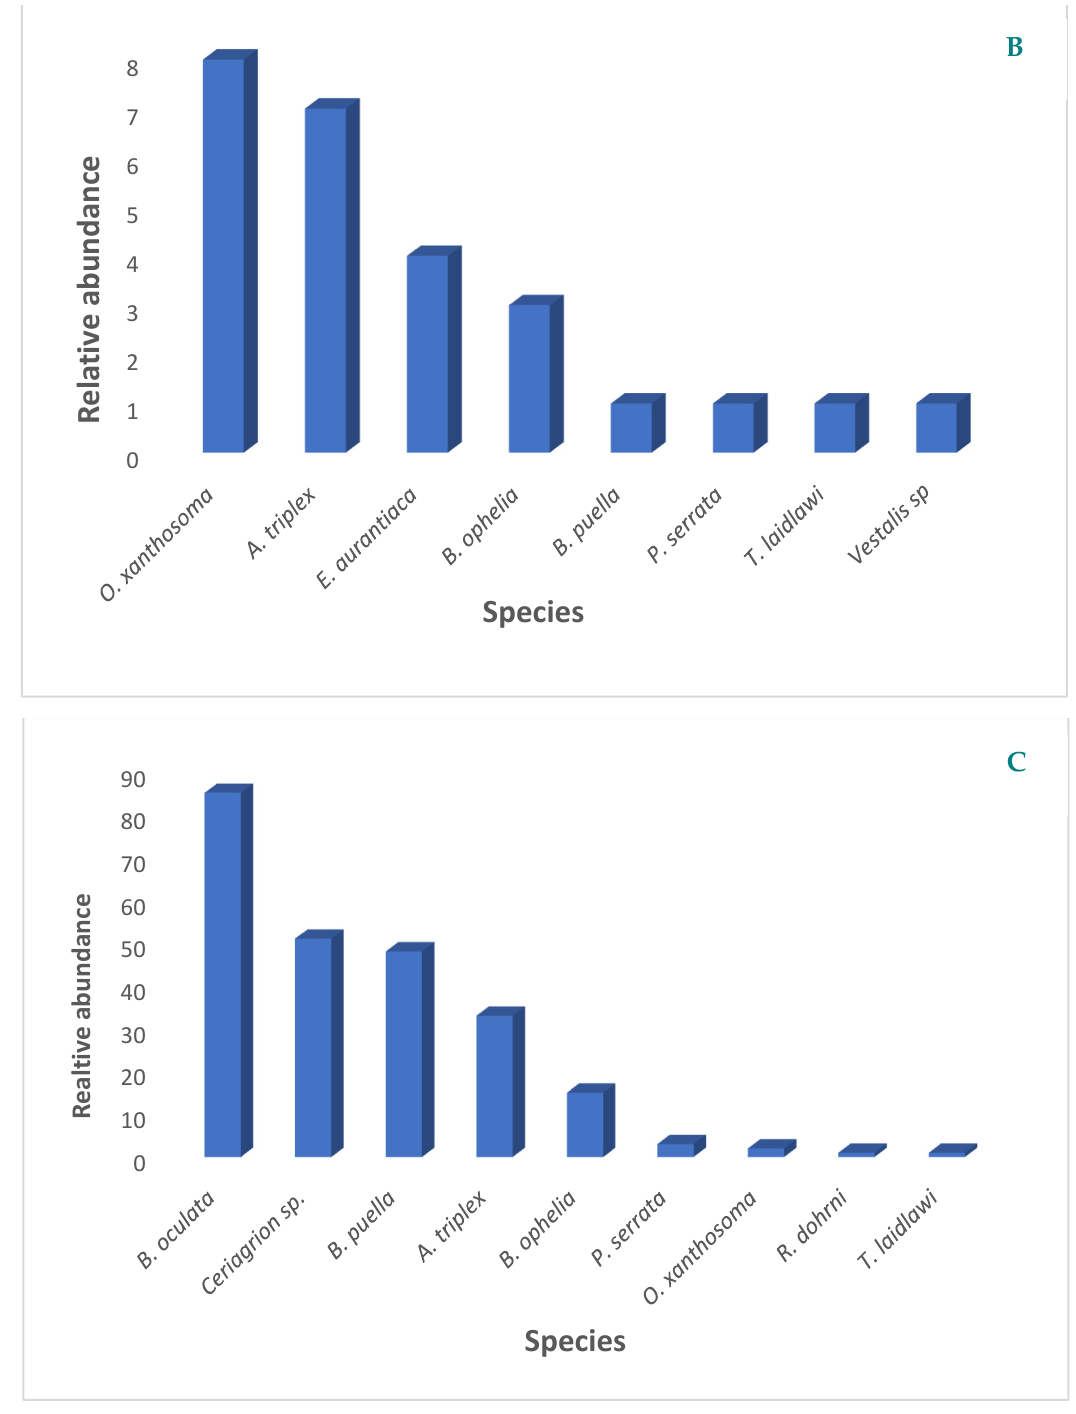
Figure A2. Relative-abundance of Odonata species in habitat-types ( A ) mixed peat swamp, ( B ) kerangas, and ( C ) low pole peat swamp habitat.